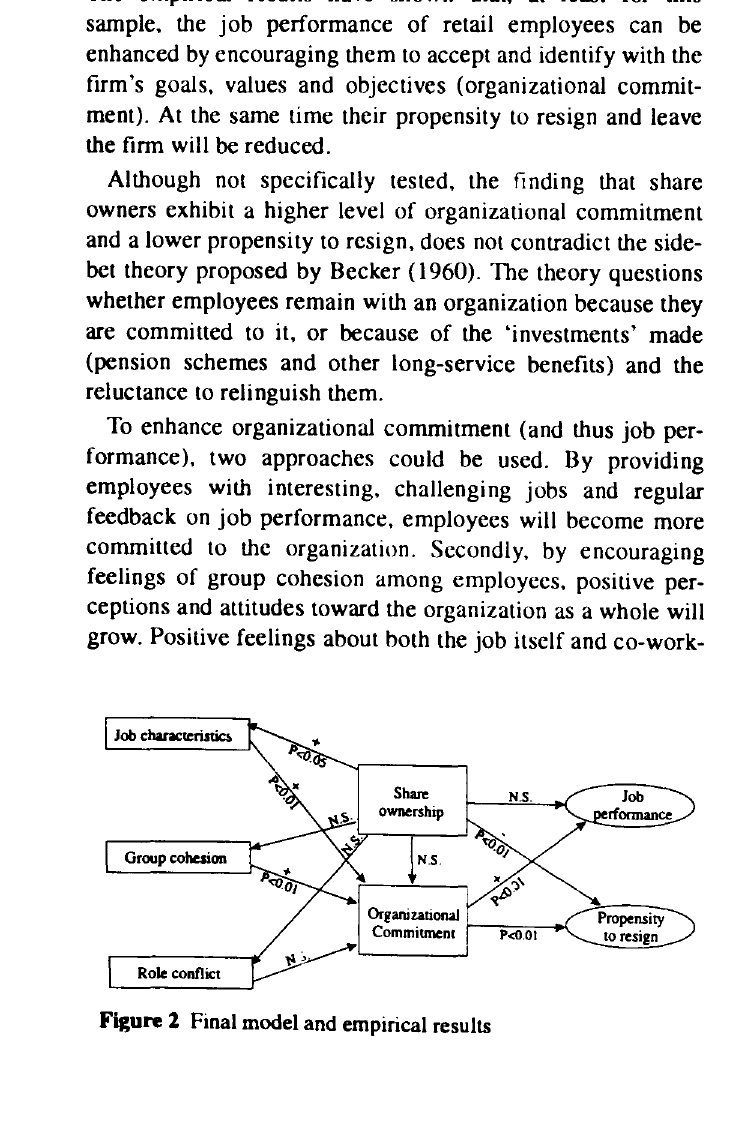
Figure 2 Final model and empirical results